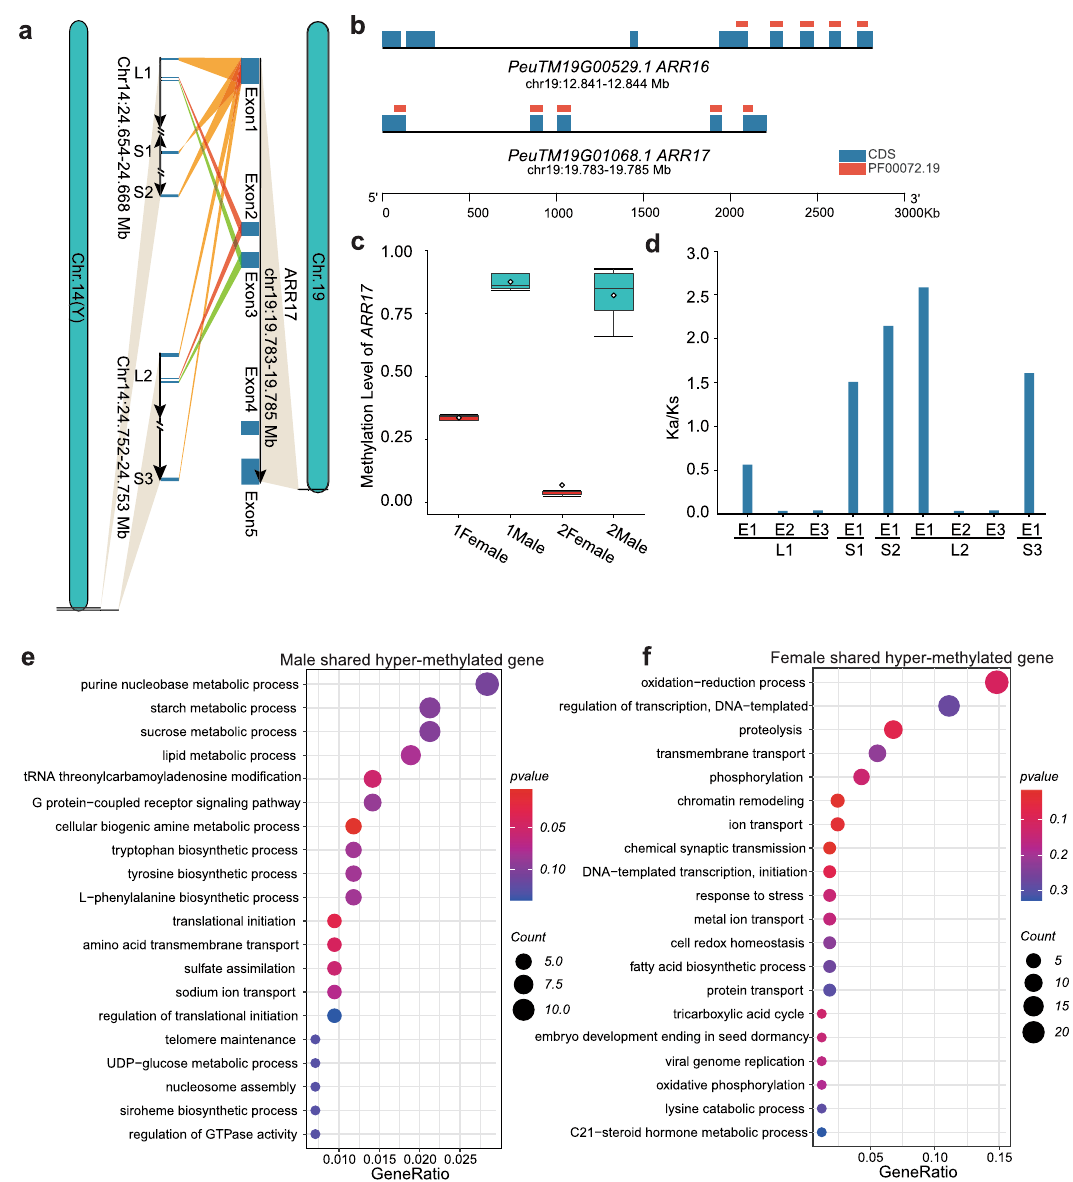
Fig. 4 Differential methylation levels of ARR17 in males and females contributing to the sex determination in P. euphratica . a ARR17 on chromosome 19 is partially duplicated in MSY-III of chromosome 14 (Y). b Schematic representation displaying the coding sequences of ARR17 and its paralogous gene ARR16 on chromosome 19 of P. euphratica . c Methylation levels at the ARR17 locus in young stems from female and male P. euphratica plants in different environments. 1 and 2 represent samples from two different environments. In the box plot, center lines indicate the median, box limits indicate the fi rst and third quartiles. d Analysis of the selective pressure on ARR17 exons, as represented by Ka/Ks ratios. e , f Separate GO term enrichment analysis for male- speci fi c and female-speci fi c hypermethylated genes (biological encoding an NB-ARC (nucleotide-binding adapter shared by Apaf1, certain R proteins and CED4) domain (Supplementary Data 21). Their best hits in the P. trichocarpa genome were Potri.014G003600 and Potri.004G170232 , respectively, both of which encode members of the resistance gene analog (RGA)